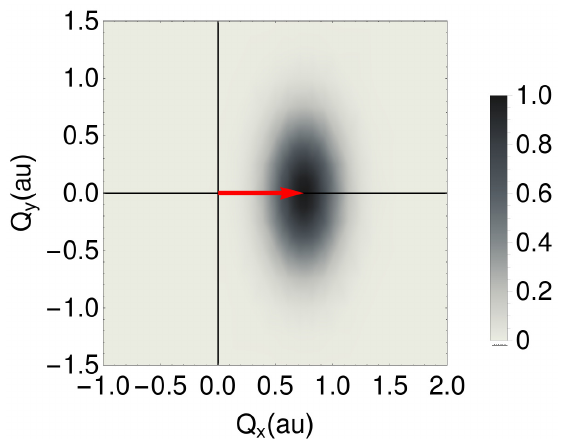
Figure 1. Density plot of the Gaussian Kernel used in our calculations in the x − y plane (i.e., θ e = 90), for σ x = 0.3 au and σ y = 0.6 au. The red arrow corresponds to the momentum transfer projection in that plane, Q x = 0.75 and Q y =